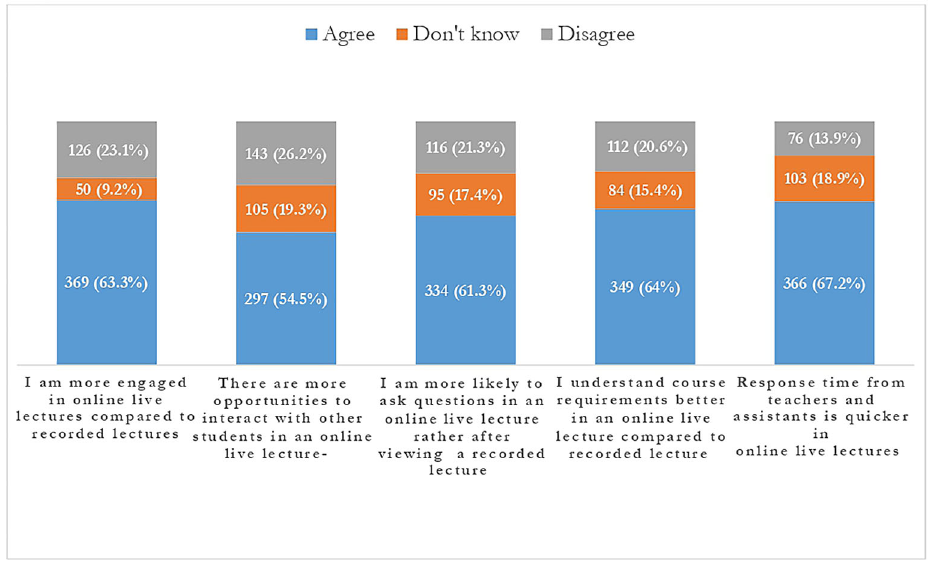
Figure 6. Students ’ reaction to live